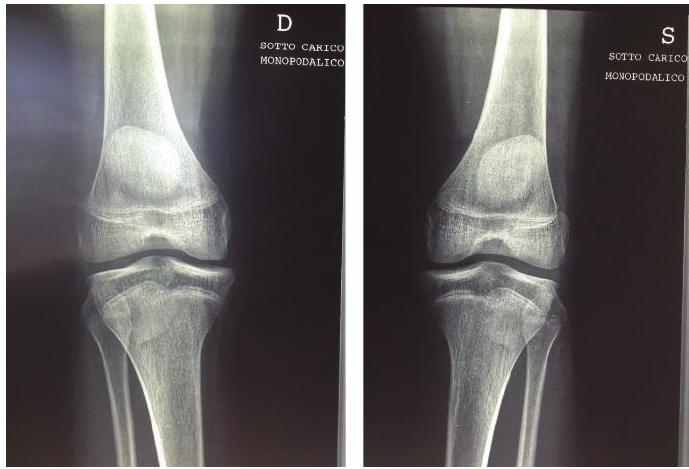
Figure 1: Anteroposterior view of the knees. Note the absence of the tibial